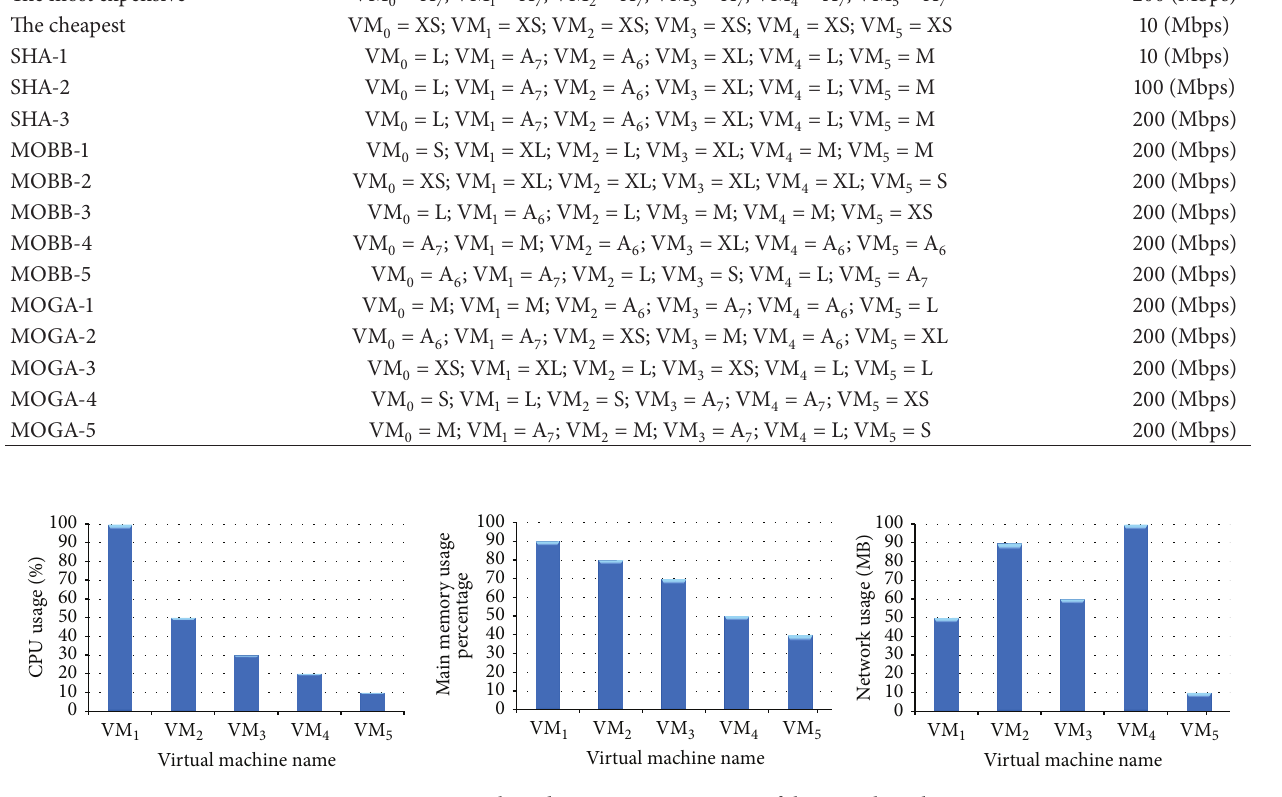
Figure 14: CPU, network, and memory consumption of the virtual machines.